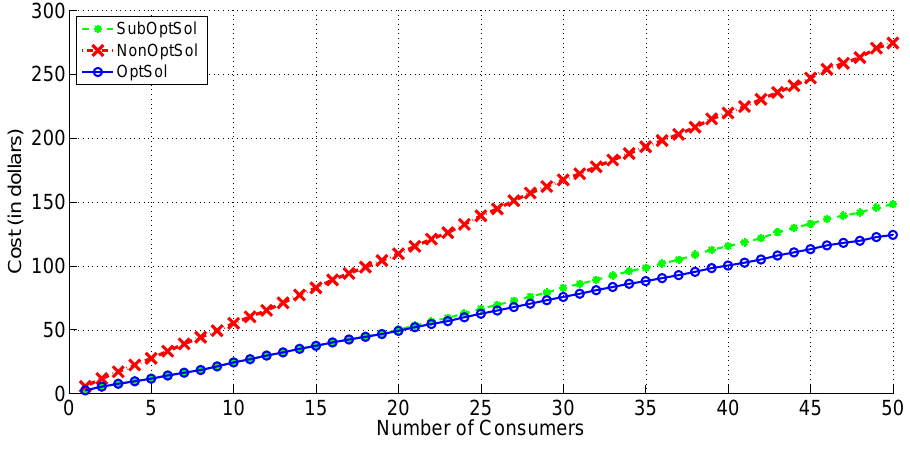
Figure 3. Sum Cost Minimization: Number of Consumers v/s